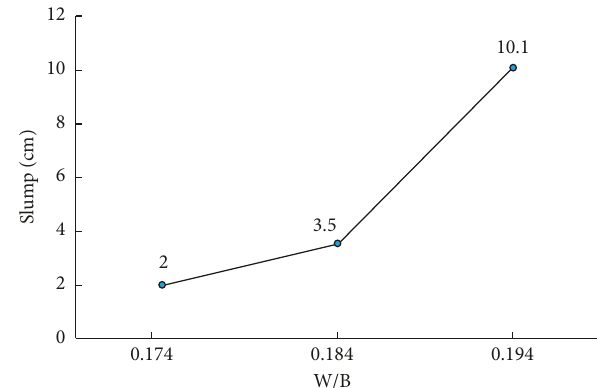
Figure 8: Influence of the W/B ratio on the fluidity of UHPFRC when GGBFS replaced 20% of the